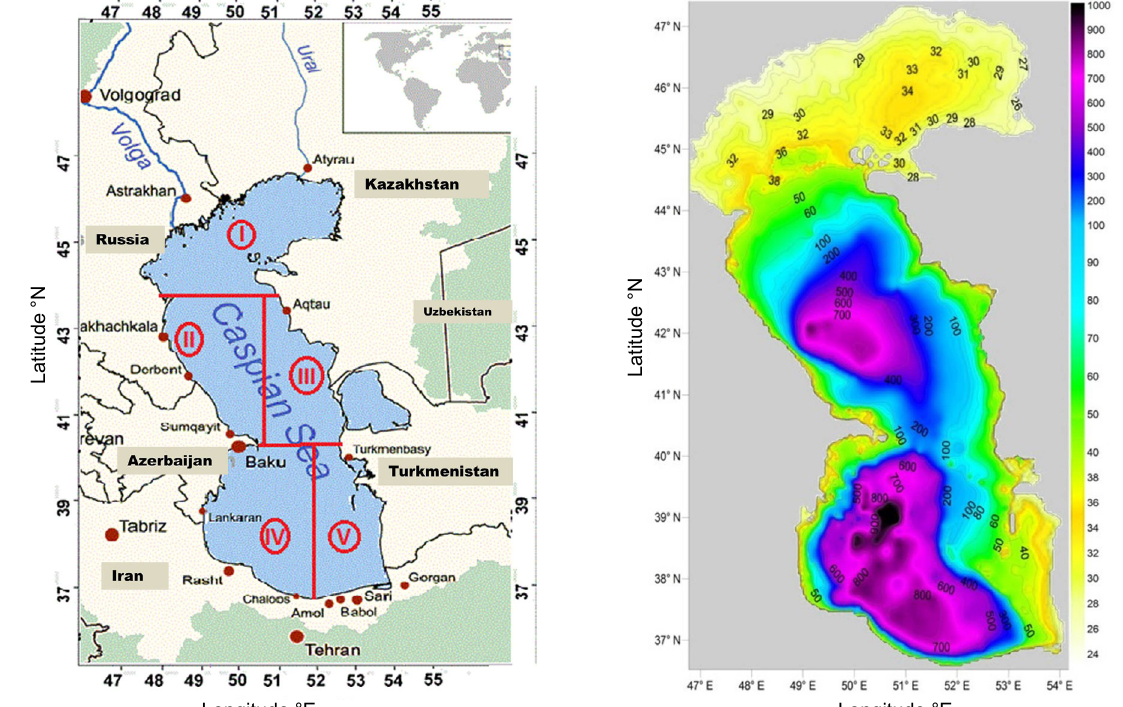
Fig. 1. The Caspian Sea is divided into five parts (left) with different wave climates and possibly different patterns of changes in wave properties (Rakisheva et al. 2019). The subregions are indicated by solid red lines: the northern part I (44  –47  N), the middle-western part II (40.5  –44  N, 47  –50.5  E), the middle-eastern part III (40.5°–44°N, 50.5  –53  E), the southwestern part IV (37  –40.5  N, 49  –52  E) and the southeastern part V (37°–40.5  N, 52  –54  E). As waves generated in the shallow Garabogazköl Basin practically do not reach the open Caspian Sea, this bay is excluded from consideration. The map of the bathymetry of the Caspian Sea (right); contours mark water depth in metres.